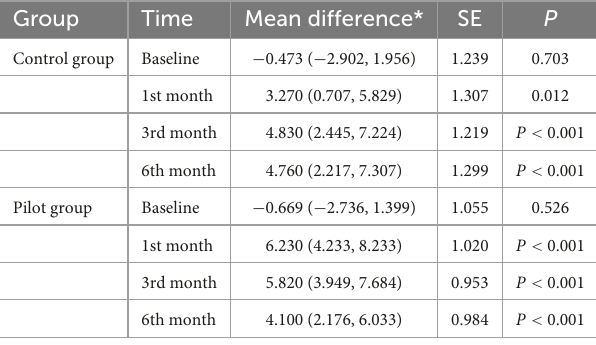
TABLE 3 Simple effect analysis of medication taking